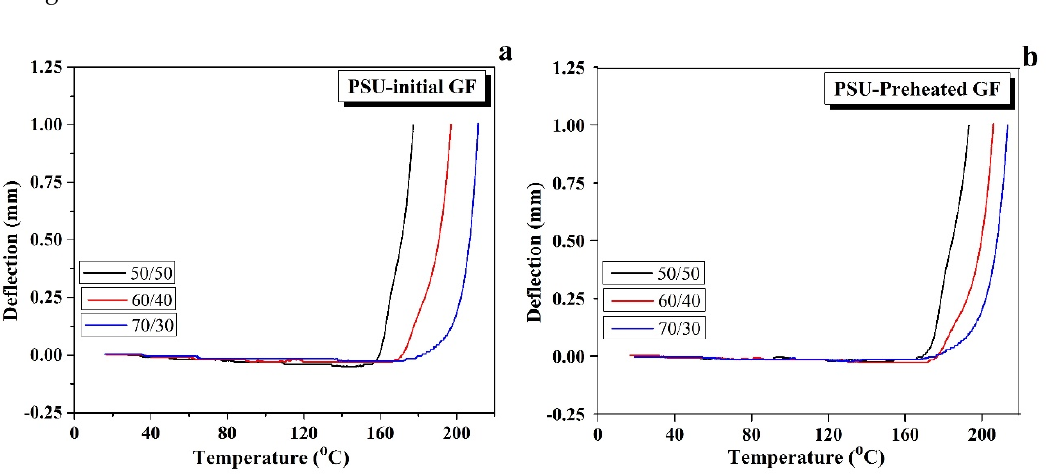
Figure 7. Heat deflection curves for ( a ) the initial and ( b ) the preheated GF reinforced composites. The values of the T g , tan δ , and HDT for the initial and preheated GF composites are given in Table 1. The T g , tan δ , and HDT values for the composites reinforced with the initial and preheated GF.